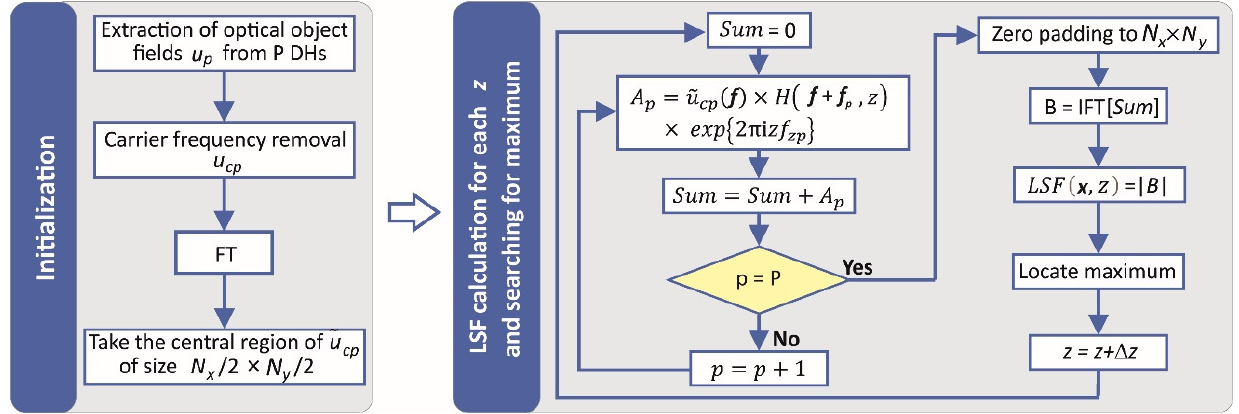
Figure 2. Diagram of numerical procedure for evaluation of LSF.